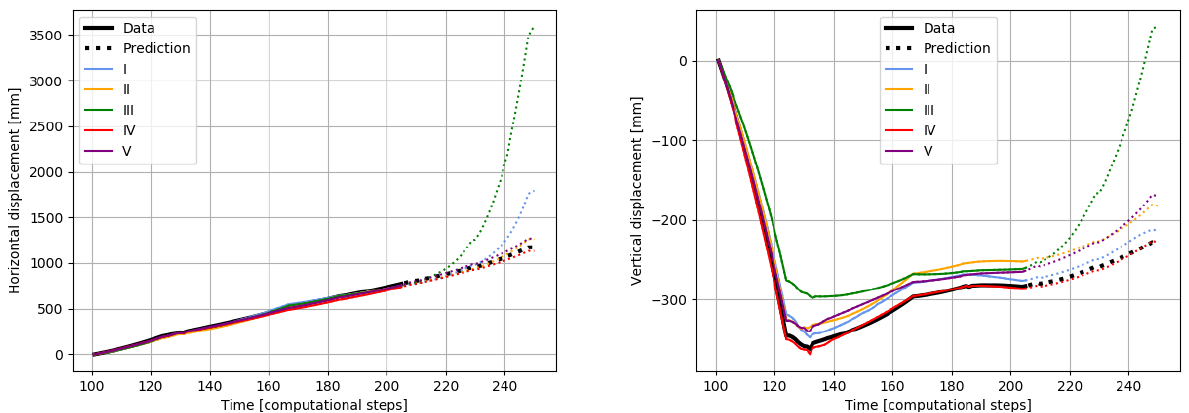
Figure 21: Predictions of horizontal (left) and vertical (right) displacement in benchmark